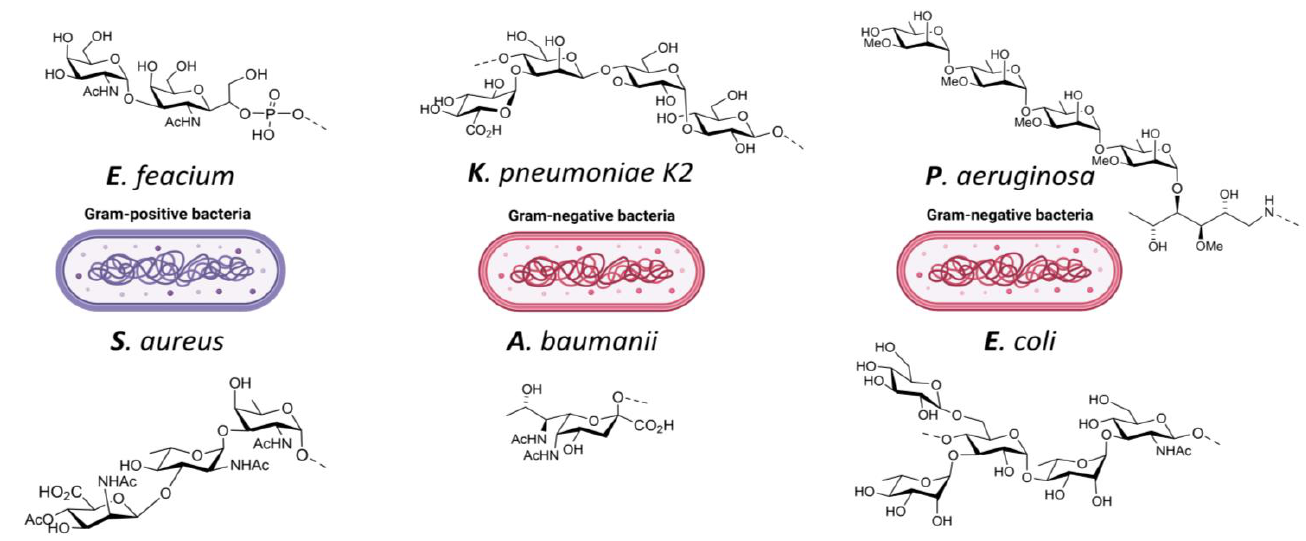
Figure 4. ESKAPE pathogens and examples of target antigens: E. feacium : cell wall teichoic acid [141];